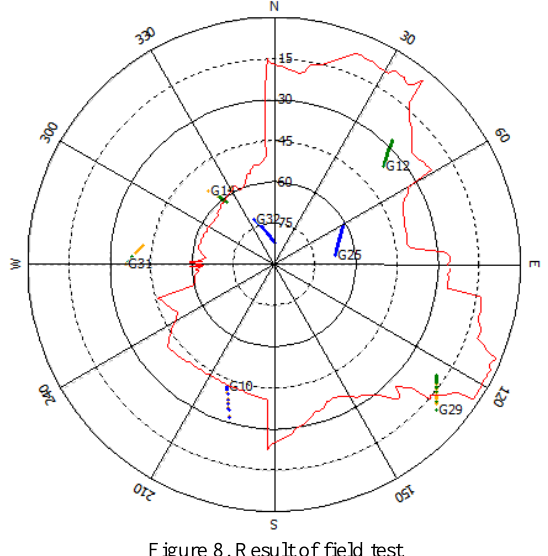
Figure 8. Result of field test